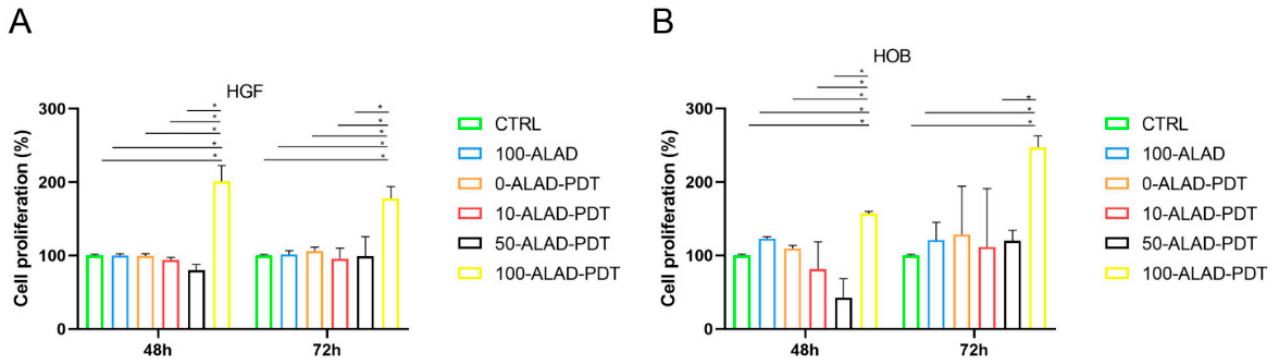
Figure 4. Cell proliferation assay. HGF ( A ) and HOB ( B )were treated with different concentrations of ALAD gel and exposed to 630 nm LED. Cell growth was measured after 48 h and 72 h. Data are expressed in percentages with respect to control (CTRL). Data are presented as mean ± SD (error bars) of three independent experiments. The proliferation rate was significantly higher with the complete treatment 100-ALAD-PDT at 48 h for HGF, and 72 h for HOB. (* p < 0.0001) .